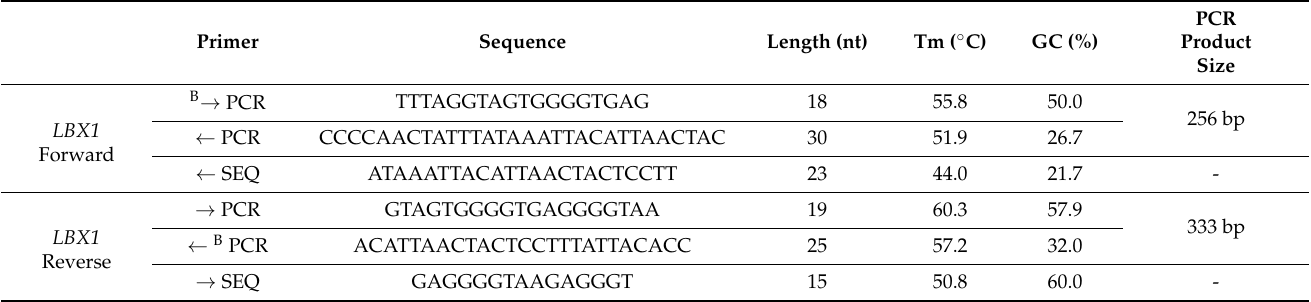
Table 1. Primer sequences designed using PyroMark Assay Design software (version 2.0.1.15; Qiagen; Hilden,